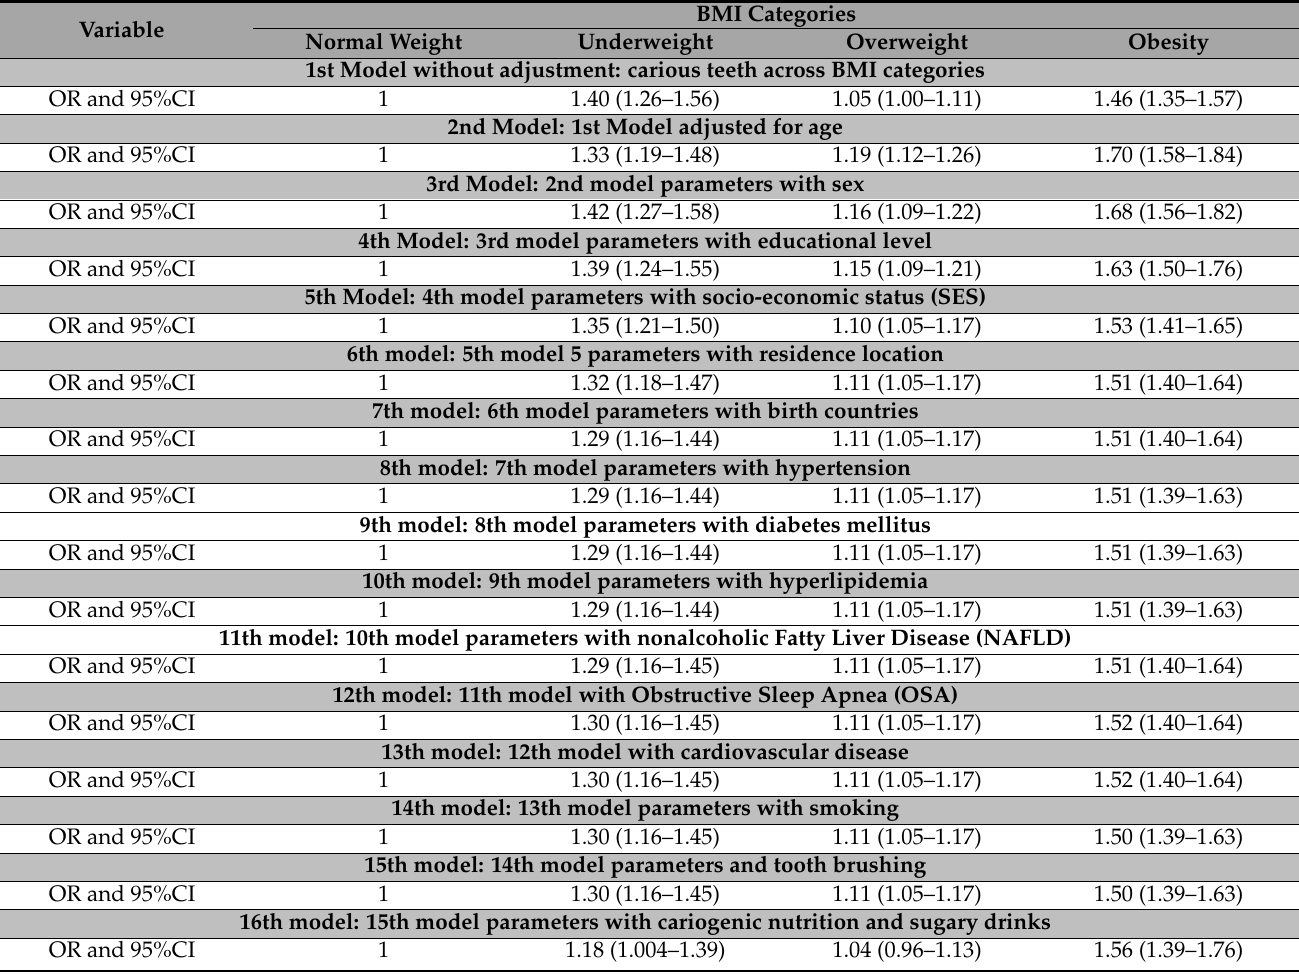
Table 3. Odds ratios (ORs) for carious teeth according to BMI categories in different general linear regression models (GLM). Description of the model applied is in background color.